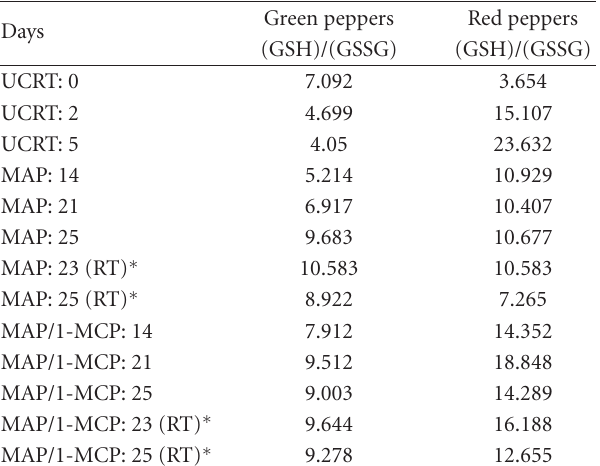
Table 2: Change in GSH/GSSG ratio in mature green peppers and fully ripe/red peppers stored at low temperature as a ff ected by the MAP and MAP+1-MCP